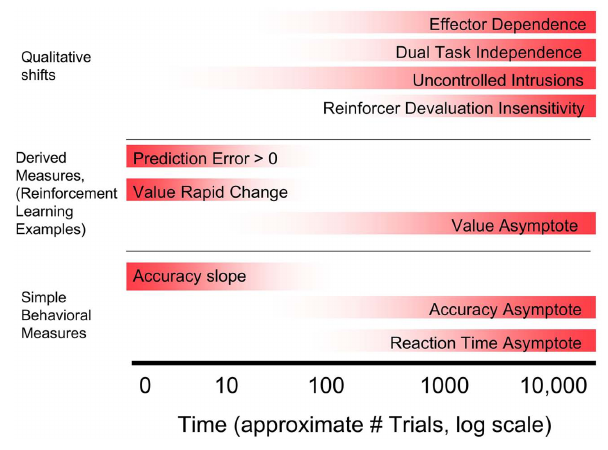
Figure 3 | Comparison of various possible criteria for habit learning that develop across learning on the basis of approximate point in training at which learning becomes habitual. Note that only criteria that can develop across training are included; criteria that are required across the entire time course of learning (unconscious, inflexible) are not. Top section: Qualitative criteria including two operational definitions of automaticity, and reinforcer devaluation. Middle and Bottom section: possible operational definitions of slow or incremental. Middle: Criteria based on computational modeling. This approach is illustrated using reinforcement-learning measures (reward prediction error, and value, or reward prediction) although other approaches can also be used. Bottom: Commonly used simple behavioral measures